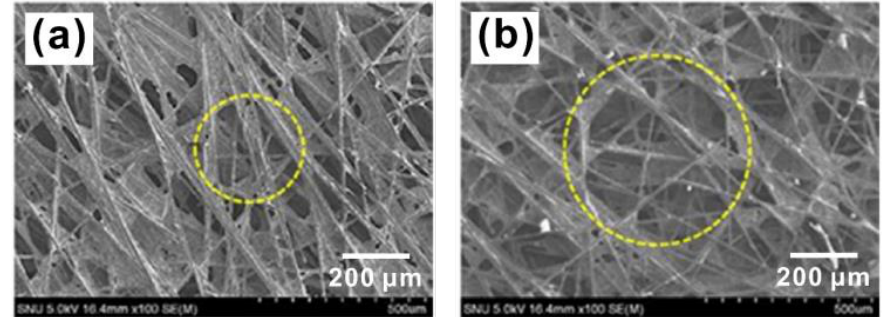
Figure 2. SEM images of carbon paper made from ( a ) short fibers and ( b ) long fibers. Yellow circles highlight the pore formed among the fibers. Reproduced with permission [41]. Copyright 2016, Elsevier.